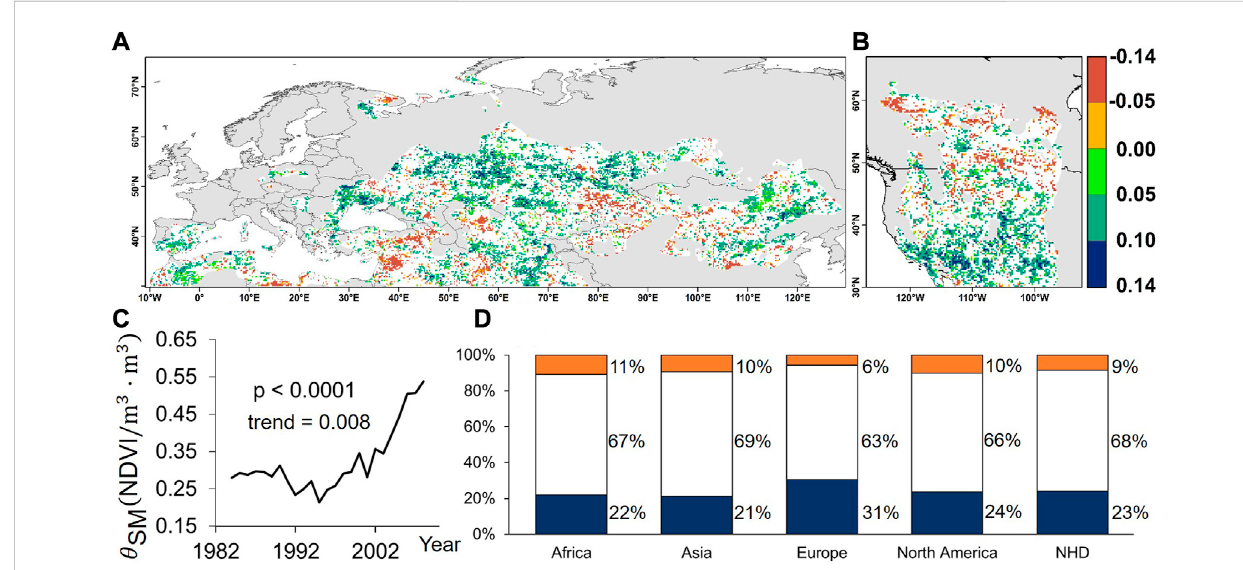
FIGURE 2 Signi fi cant positive and negative trends in vegetation-soil moisture sensitivity (Mann-Kendall test, p < 0.05) across the Northern Hemisphere drylands (NHD). The normalized difference vegetation index and soil moisture were represented by NDVI and SM. (A, B) The spatial distribution of the vegetation-soil moisture sensitivity trends across the NHD. (C) A time series of the vegetation-soil moisture sensitivity during 1982 – 2010. (D) The fractions (%) of signi fi cant positive (dark blue) and negative (orange) pixels per continent. The blanks in (A, B, D) are land fractions that underwent a non-signi fi cant